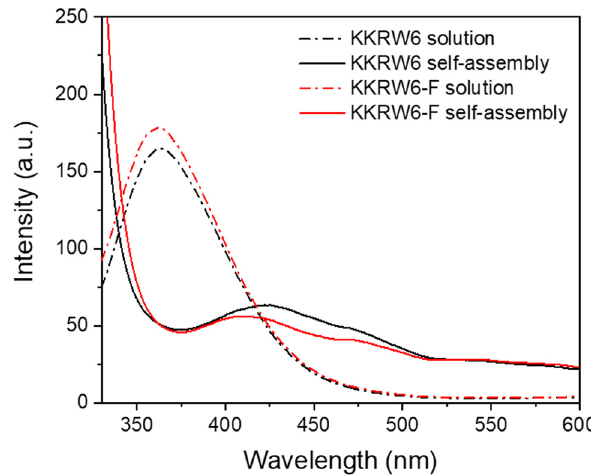
Figure 6: Fluorescence spectra of KKRW6 and KKRW6 - F peptide solutions ( 40 mg · mL − 1 , pH = 3 ) and peptide self -